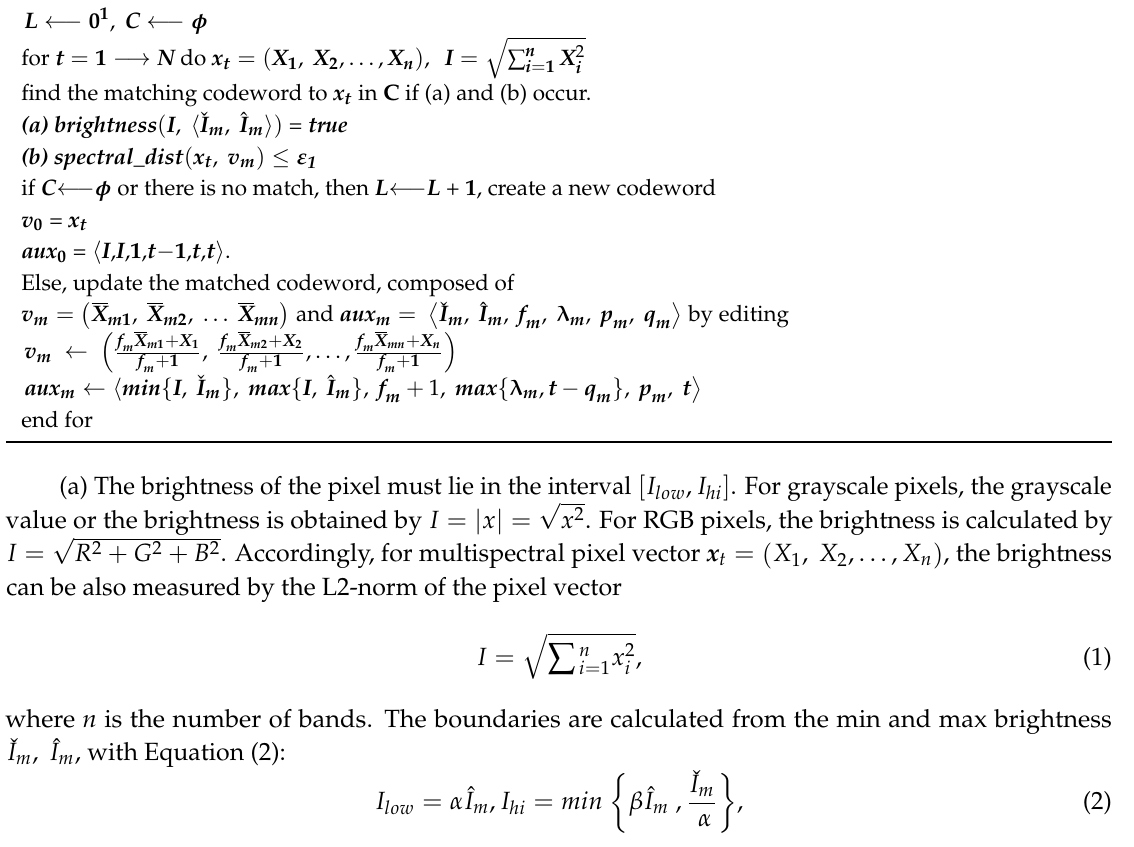
Algorithm 1 Codebook